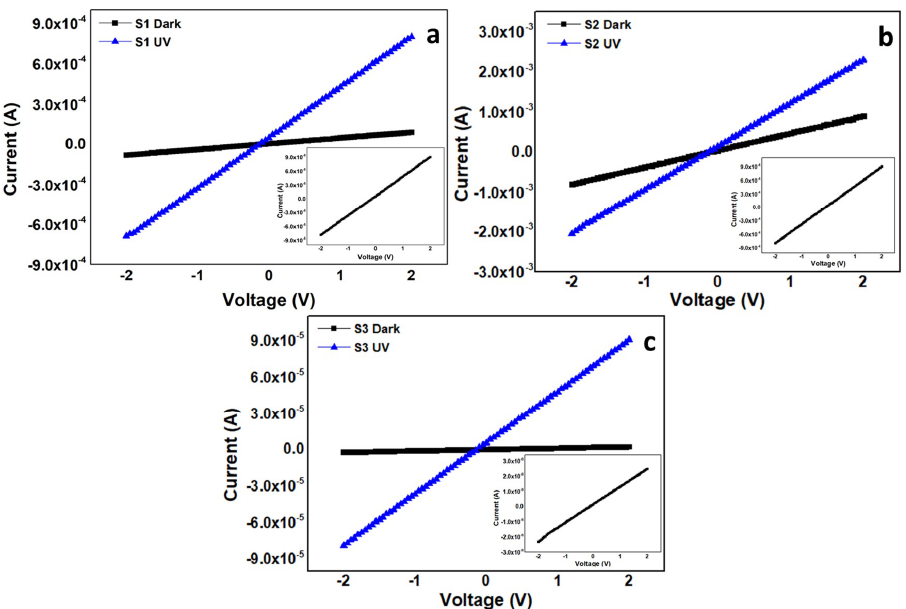
Figure 8 . Current–voltage ( I–V ) characteristics of ( a ) S1; ( b ) S2; and ( c ) S3. The insets show the magnified dark current characteristics of the corresponding samples for clarity.